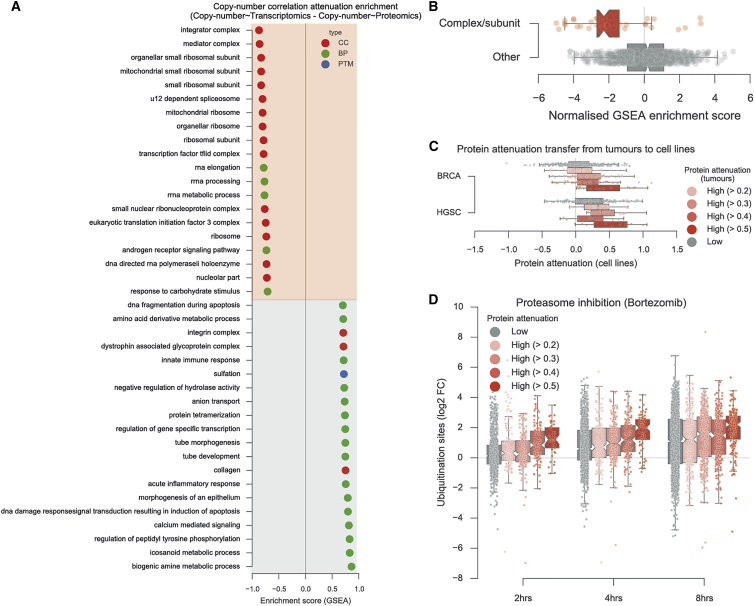
Enrichment Analysis of the Proteins Undergoing Copy-Number Attenuation(A) Enrichment analysis of the correlation differences between copy-number variation and transcriptomics and copy-number variation and proteomics. Protein subsets used represent biological processes (BP, green), cellular components (CC, red), and post-translational modifications (PTM, blue). Gene sets listed are all significantly enriched at FDR <5%.(B) The distribution of the enrichment scores for terms referring to protein complexes or subunits are represented in red and all the rest in gray.(C) Proteins classified according to their attenuation profile in tumors are mapped against their attenuation in breast and ovarian cancer cell lines.(D) Ubiquitination site fold changes over time after proteasome inhibition with bortezomib discretized according the protein attenuation level in tumors.